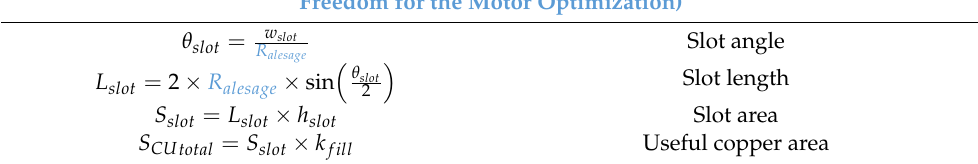
Table 4. Calculation of the slot length.